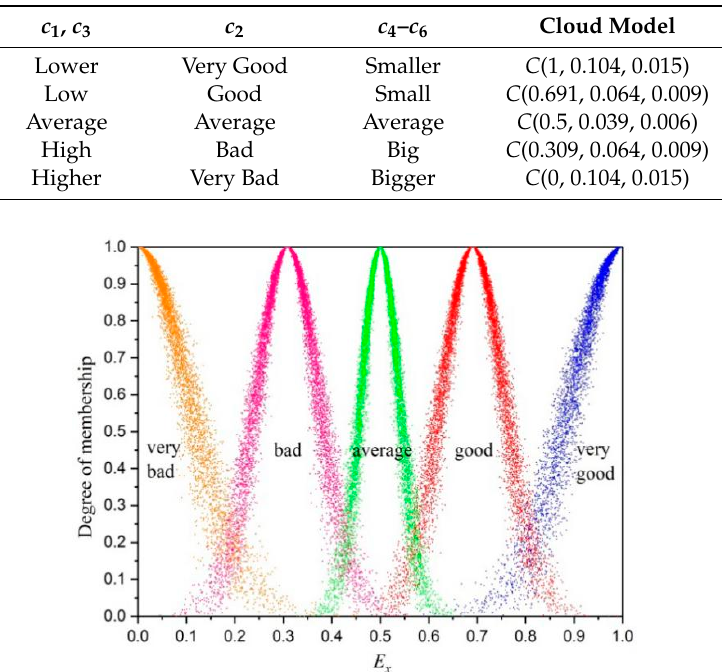
Table 1. The corresponding cloud model of the qualitative indicators. Table 1 . The corresponding cloud model of the qualitative indicators.